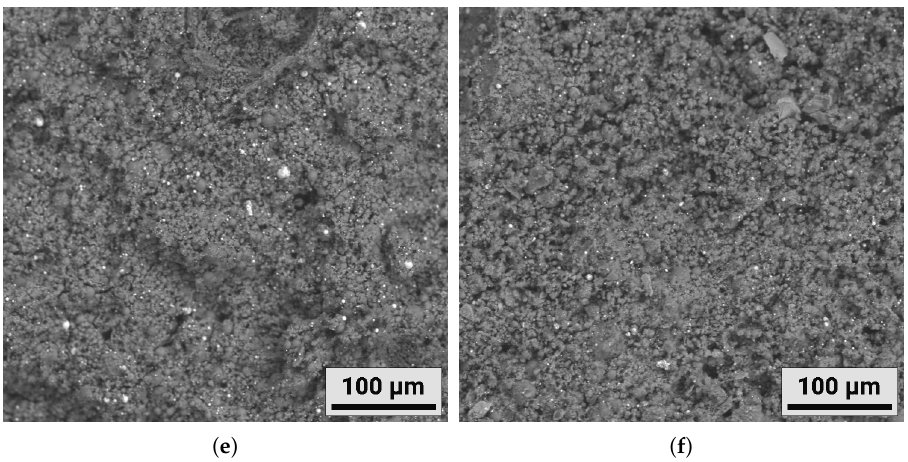
Figure 4. Fracture surfaces of TAW1 ( a , b ), TAW2 ( c , d ), and TAW3 ( e , f ) samples after vacuum sintering ( a , c , e ) and HIP ( b , d , f